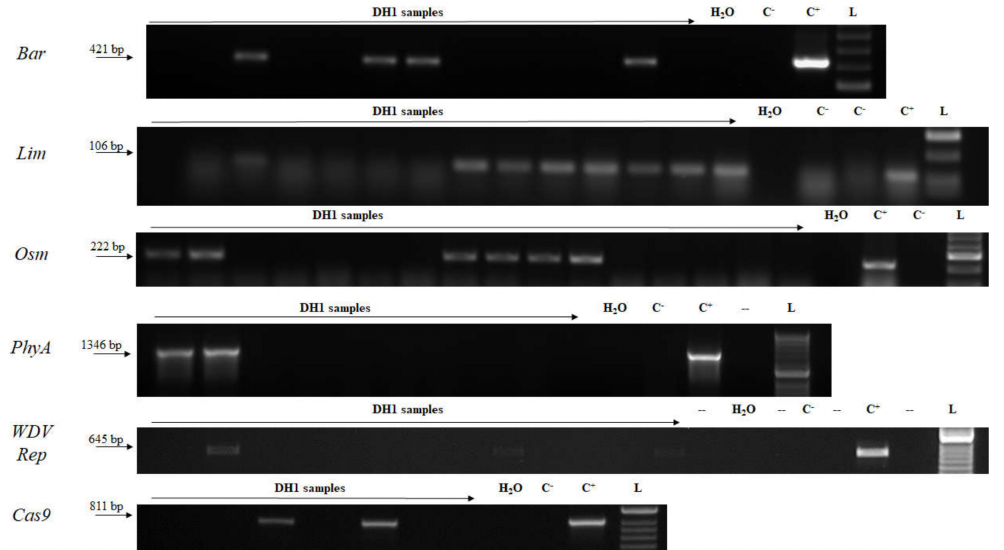
Figure 3. Detection of the transgenes in anther culture regenerants. L—DNA ladder (HyperLadder 50-bp, Bioline); C + —genomic DNA from T0 transgenic plant; C − —wild-type plant; DH1—samples of anther culture regenerants. Bar —barnase; Lim —limen; Osm —osmotin; PhyA —phytase;